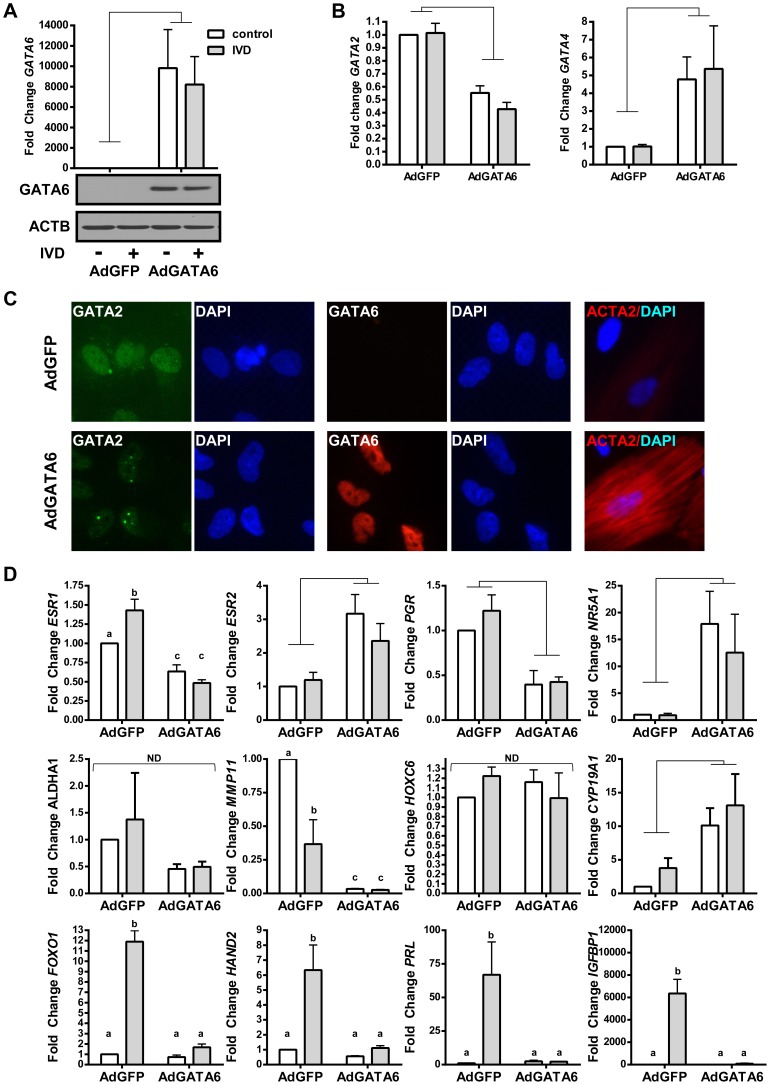
The effects of GATA6 expression in EIUM.(A) Adenoviral-mediated expression of GATA6 (AdGATA6) resulted in significant mRNA (top) and immunoreactive protein (bottom) relative to cells transduced with an adenovirus expressing GFP (AdGFP). IVD did not significantly affect GATA6 expression. (B) qPCR showed that GATA6 transduction was the main affect for the repression of GATA2 and the induction GATA4 mRNA. (C) Immunofluorescence for GATA2 (pseudocolored green), GATA6 (red; middle panels), and ACTA2 (red; right panels) is shown for AdGFP-transduced cells (top row) and AdGATA6-transduced cells (bottom row). Transcription factors showed proper nuclear staining, and GATA2 nuclear signal was reduced when GATA6 was present (DAPI counterstaining is shown beside panels for transcription factors). ACTA2 immunoreactivity was observed in AdGATA6 transduced cells similar to OSIS (compare to figure 1; DAPI counterstain is merged). (D) qPCR was performed on the same panel of 12 genes shown in Figure 1, and EIUM cells transduced with AdGATA6 resulted in a shift in gene expression that resembled OSIS. AdGATA6 was the main effect for the observed change in ESR2, PGR, NR5A1, and CYP19A1. A significant interaction was observed between AdGATA6 treatment and IVD for ESR1, MMP11, FOXO1, HAND2, PRL, and IGFBP. HOXC6 and ALDH1A2 were not significantly affected by either treatment. (n = 4; connecting bars show main effect p<0.05 by 2-way ANOVA; lower case letters indicate significantly different groups p<0.05 by Tukey's after ANOVA).